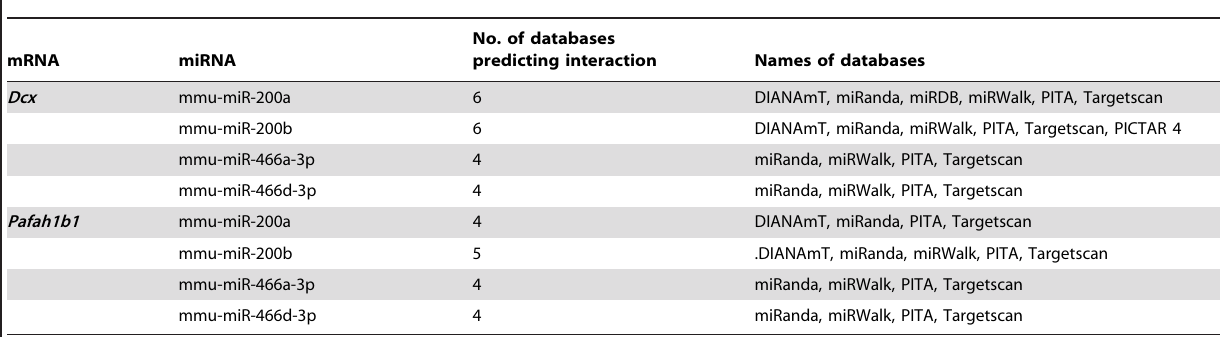
Table 2. miRNA and mRNA target prediction by